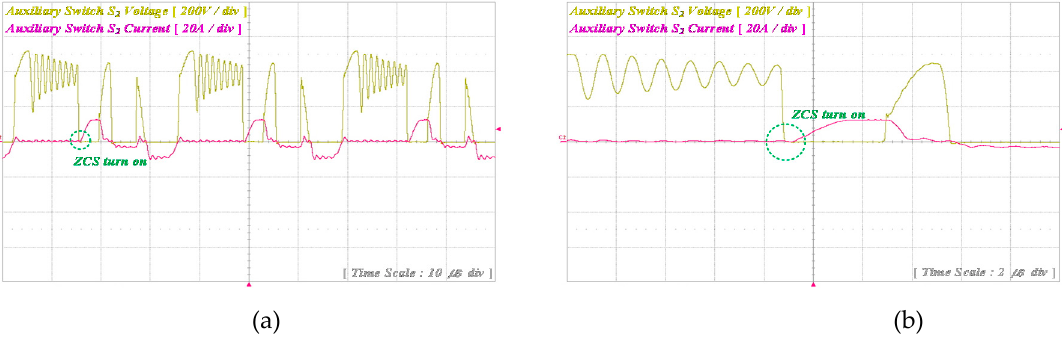
Figure 21. ( a ) Waveforms of auxiliary switch S 2 voltage and current and ( b ) expansion waveforms of S 2.